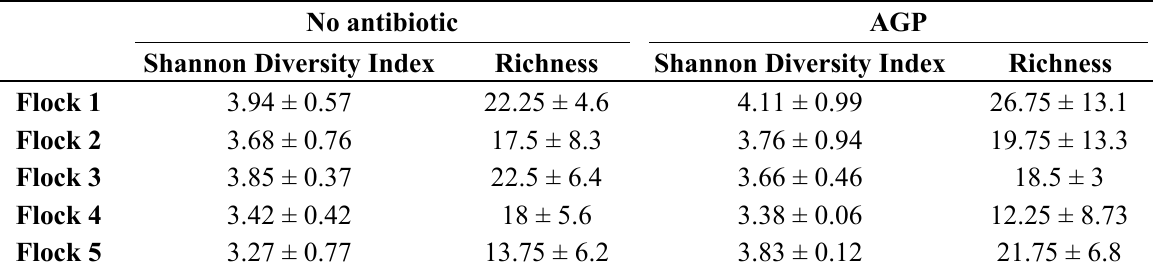
Table 3. Diversity of bacterial communities determined by 16S rRNA T-RFLP signal of litter from 5 sequential flocks of broiler chickens raised on commercial poultry farms. Two houses on each farm contained birds that were fed the AGP flavomycin or flavomycin + virginiamycin; two houses contained birds that were not fed antibiotics.